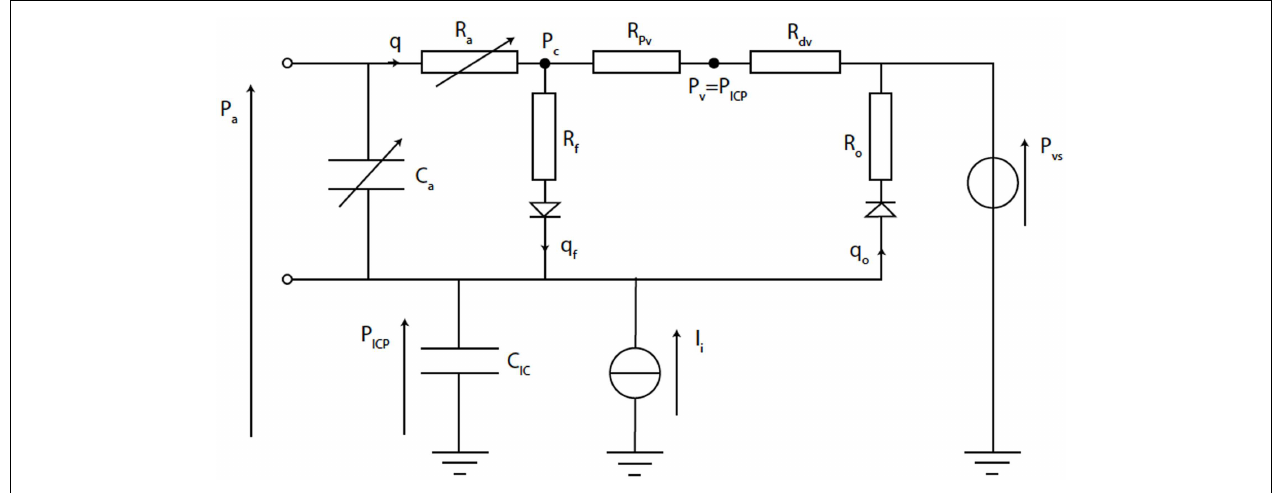
dependent upon the volume stored in intracranial compliance ( C IC ).This is dependent upon blood volume in C a , CSF inflow ( q f ) through inflow resistance ( R f ), and CSF outflow ( q o ) through outflow resistance ( R o ), which is itself dependent upon venous sinus pressure ( P vs ).The system can be disturbed by mock CSF injection ( I i